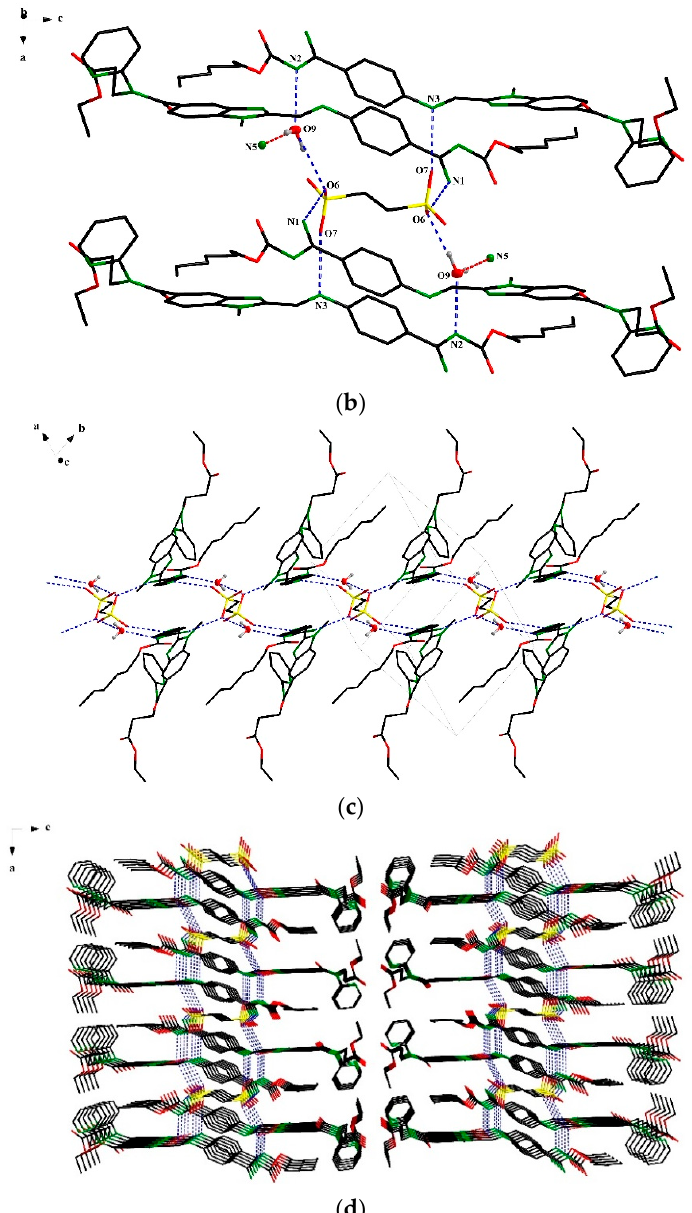
Figure 2. Crystal structure of DBE monohydrate: ( a ) Protons of the O(7) atoms of the edisilic acid were transferred to the N(2) atoms; ( b ) Intermolecular hydrogen bonds between DBE and water molecules; ( c ) Intermolecular hydrogen bonds between DBE molecules; ( d ) Crystal structure of DBE showing the 3-D network. Table 2. Inter- and intra-molecular hydrogen bond in DBE monohydrate 1,2 . Type